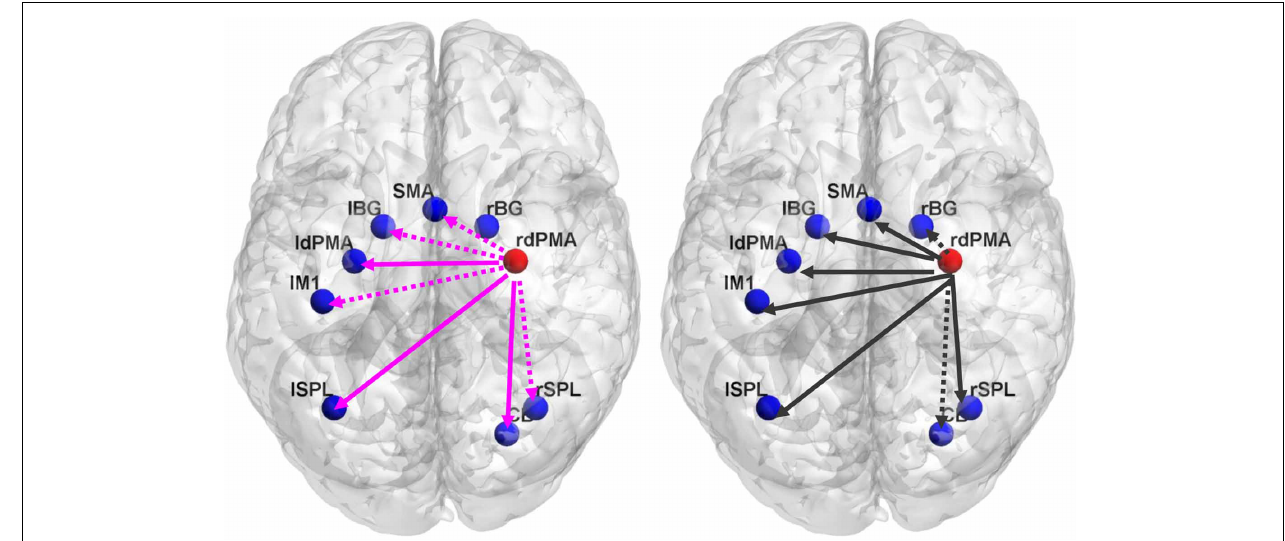
FIGURE 5 | The difference of Granger causality index between TrainD and TrainA in the experiment group (left) and the control group (right). The pink color line represents the increased Granger index from TrainA to TrainD, and the black color line represents the decreased index from TrainA to